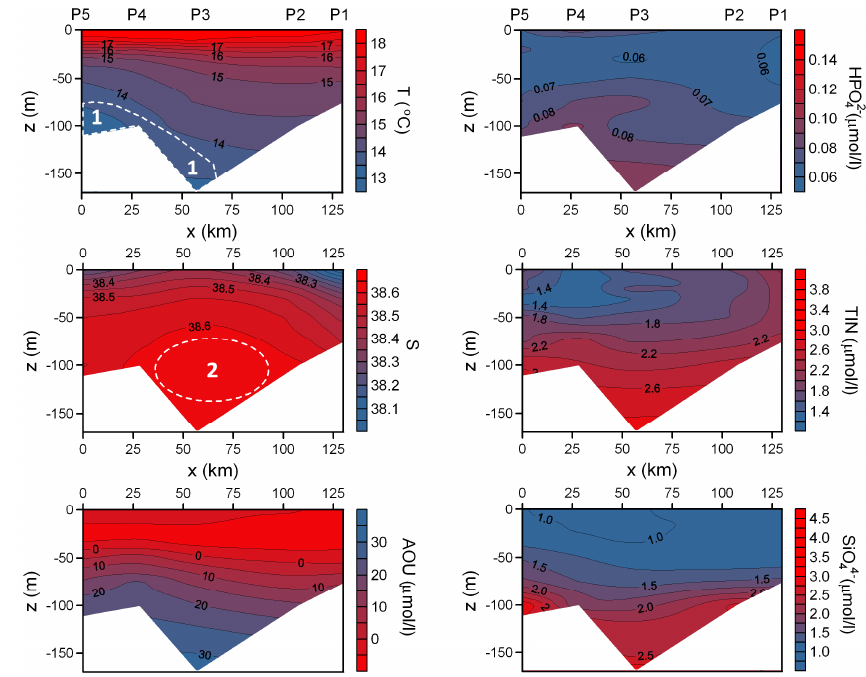
Figure 7. Palagruža Sill profiles of temperature, salinity, AOU, orthophosphates, TIN and orthosilicates, averaged between 1960 and 2010. NAdDW outflow area is marked by 1, and LIW core area by 2. South is to the left.